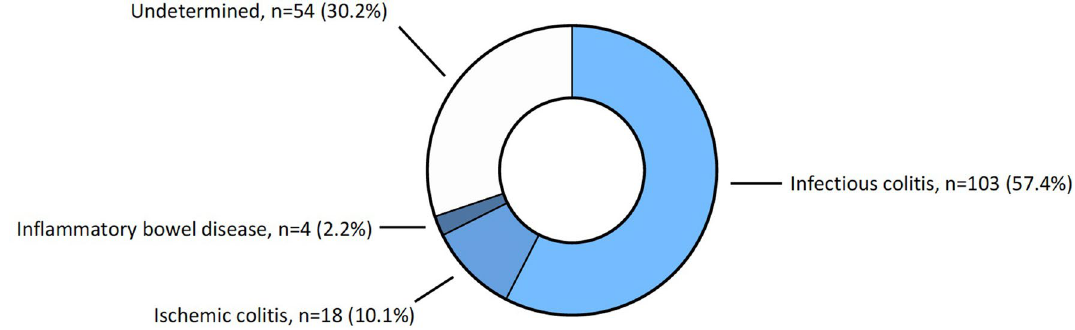
Figure 3. Etiologies of acute colitis were looked for using microbiological screening of the feces (BD-Max and FilmArray GI panel) and diagnostic colonoscopy in those with negative routine PCR